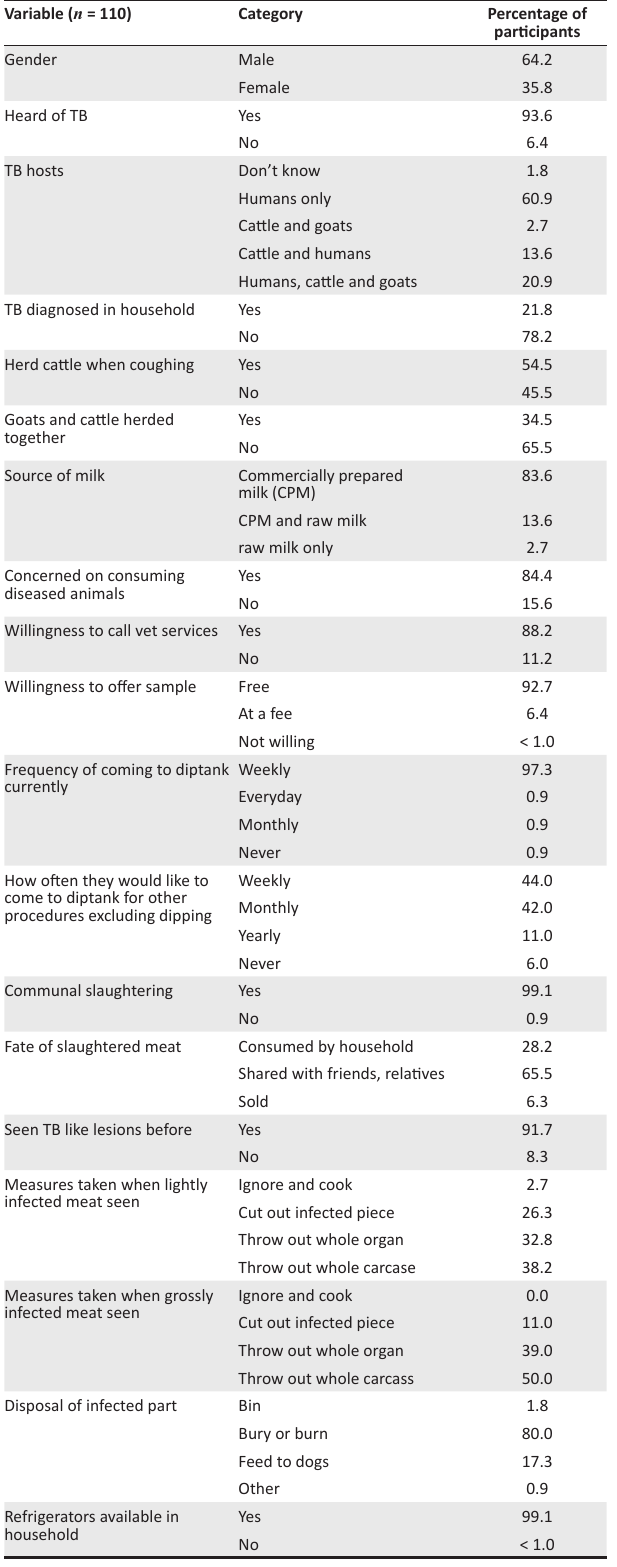
TABLE 1: Mnisi community tuberculosis questionnaire results. Variable ( n = 110)